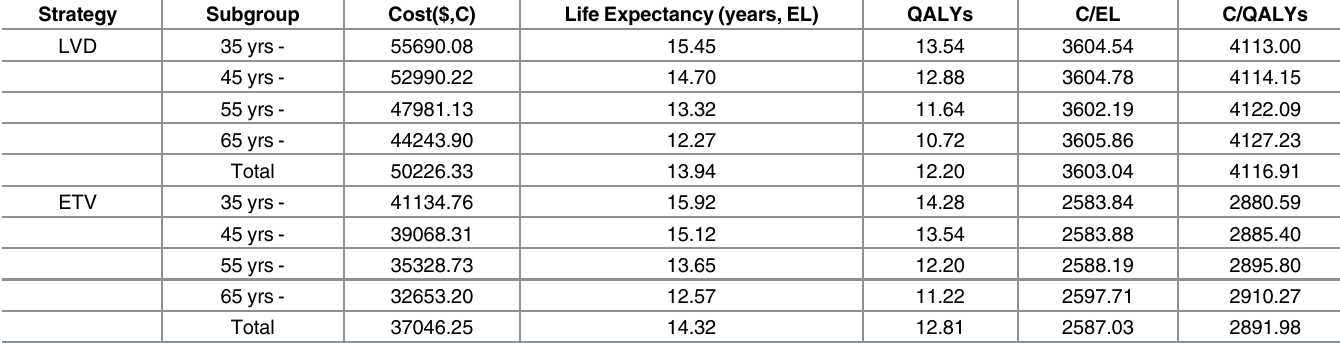
doi:10.1371/journal.pone.0161936.t004